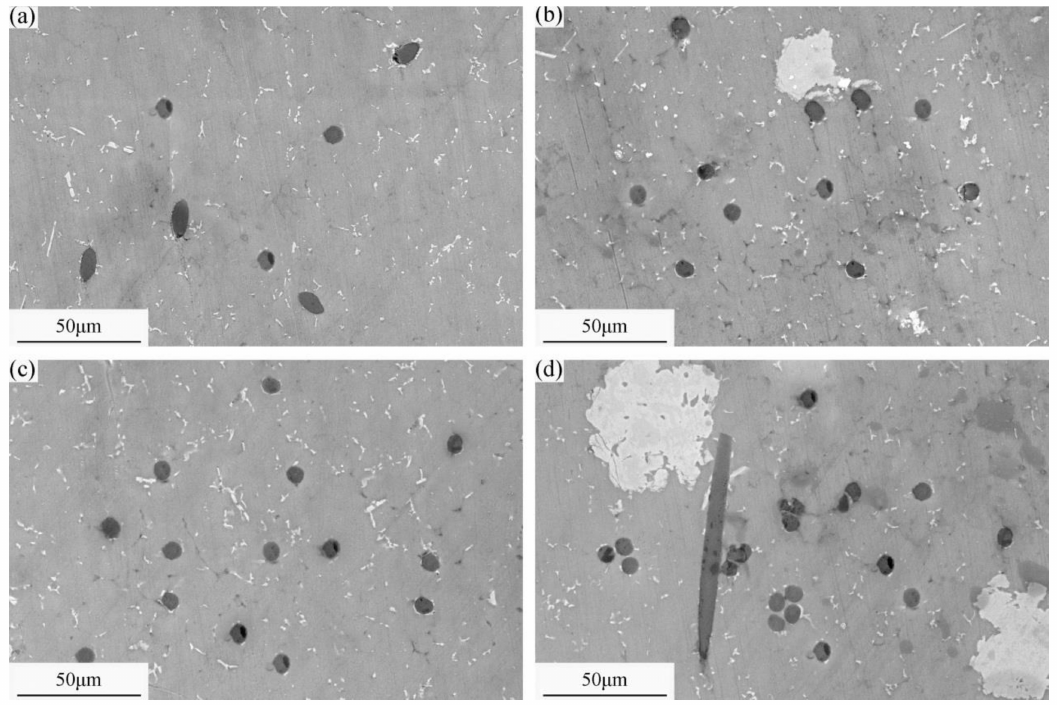
Figure 6. SEM images of the microstructures of SCFs / Al composites with di ff erent SCF contents: ( a ) 2%; ( b ) 4%; ( c ) 6%; and ( d )